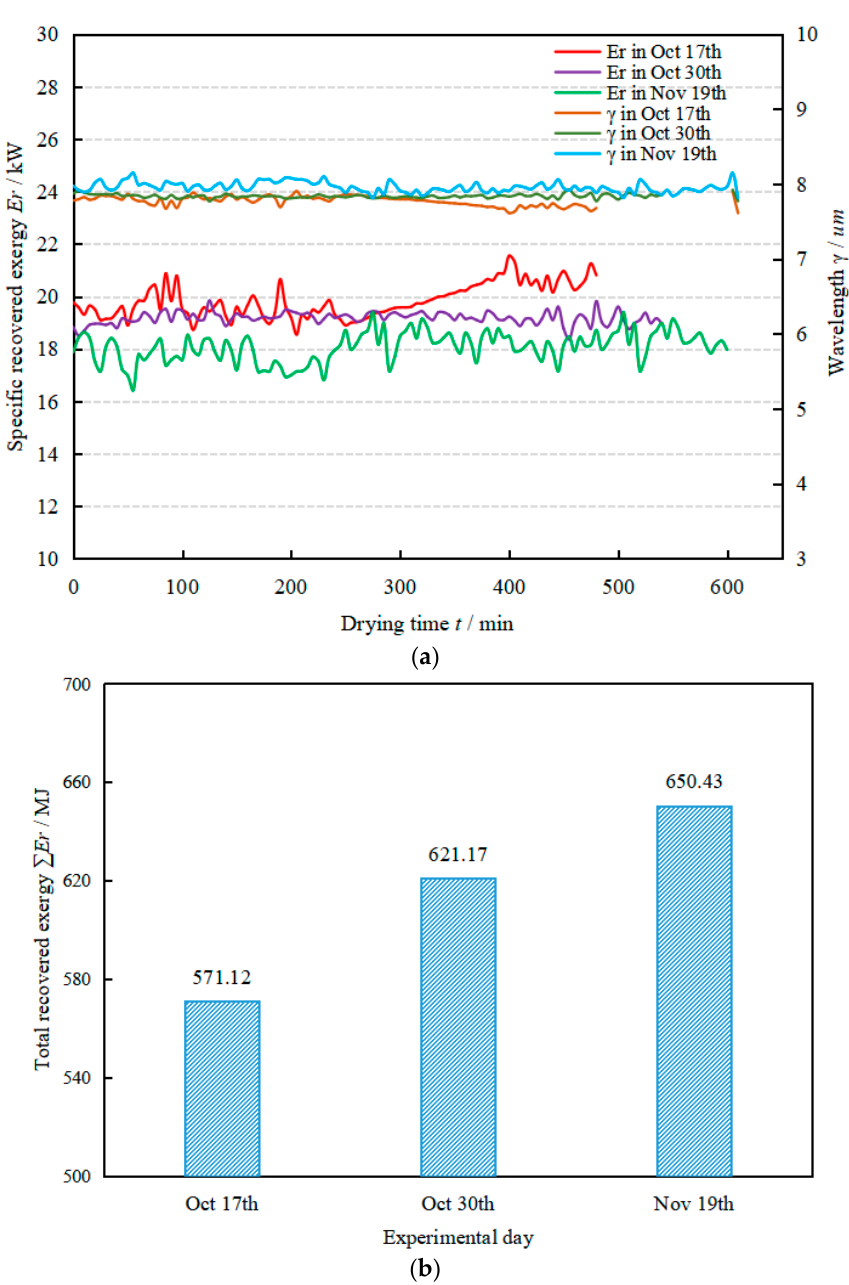
Figure 7. The variations of specific recovered exergy, wavelength with drying time ( a ) and the total exergy recovered by the radiator ( b ).